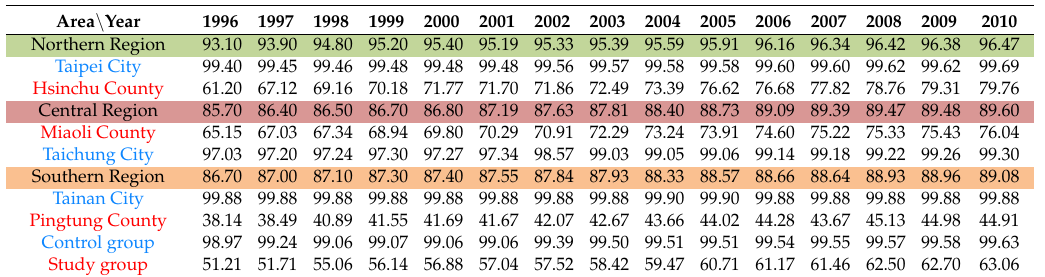
Figure 1. Study areas from the northern, central, and southern regions of Taiwan (red font: study group; blue font: control group). Table 1. Piped water prevalence in study areas during 1996–2010 (red font: study group; blue font: control group; unit: %).